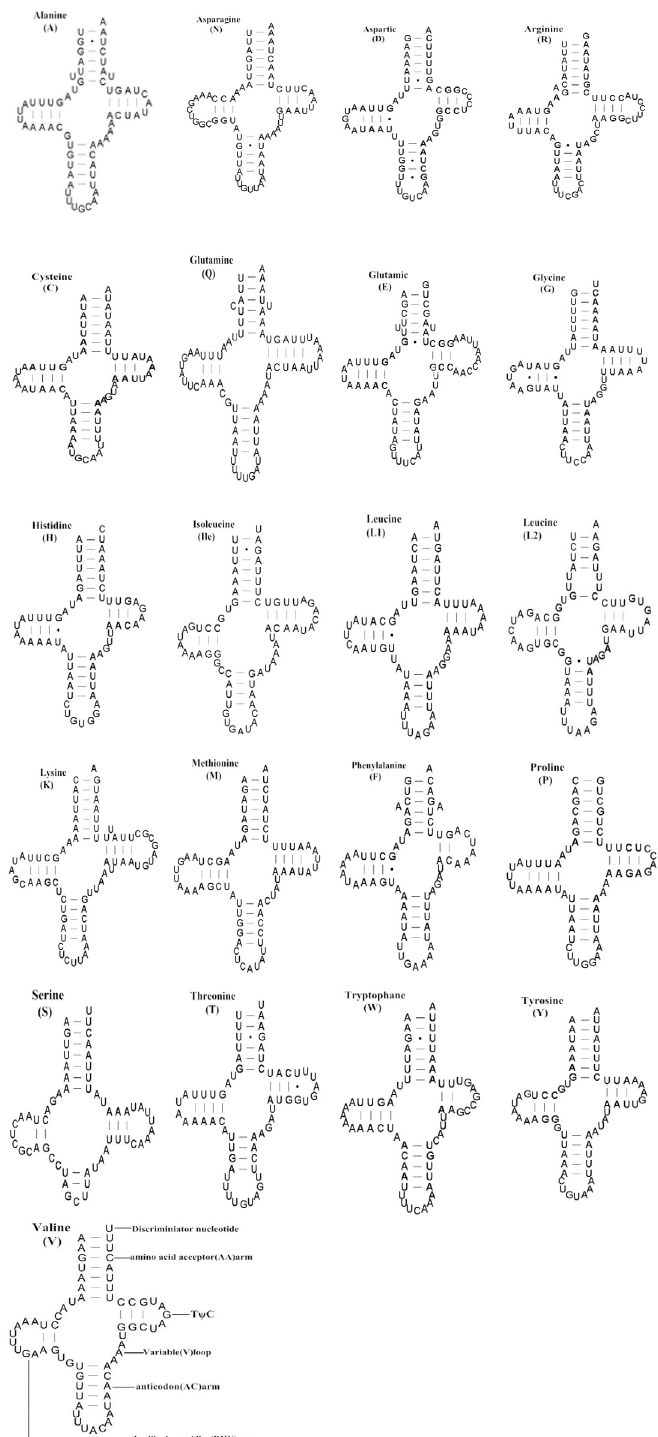
Fig 4. Inferred secondary structures of 21 tRNAs from the A . spiniferus mitogenome. The tRNAs are labelled with the abbreviations of their corresponding amino acids. Dashes (-) indicate Watson-Crick bonds and dots ( (cid:1) ) represent GU bonds. Each arm and loop is illustrated for trnV .